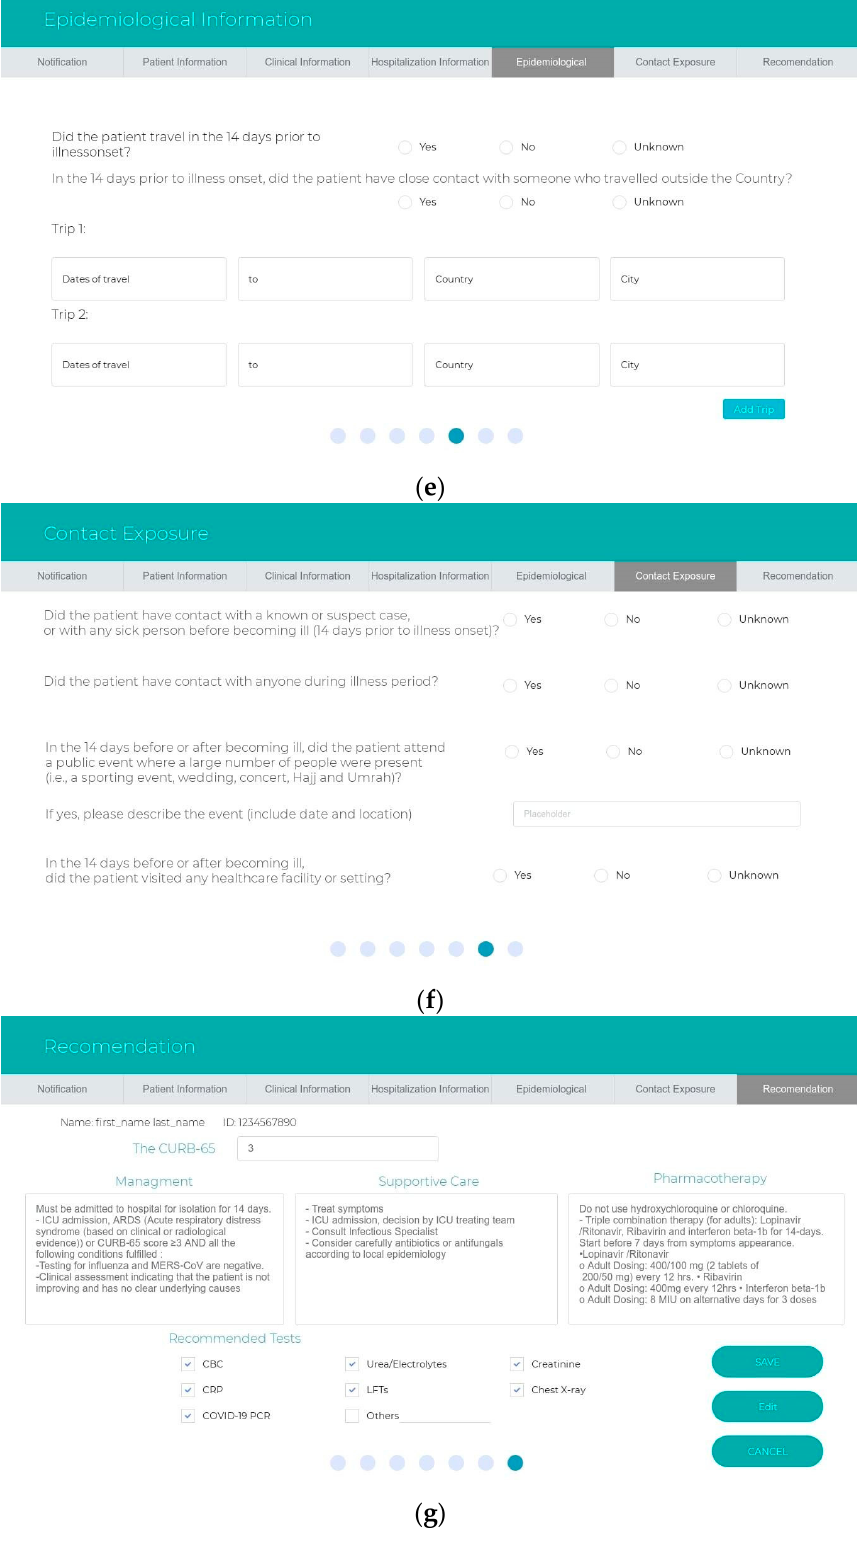
Figure 2. The prototype interfaces for the sub-system. The information management system: ( a , b ) patient information, ( c ) clinical data, ( d ) hospitalization, ( e ) epidemiological information, ( f ) contact exposure, and ( g ) expert system recommendation.